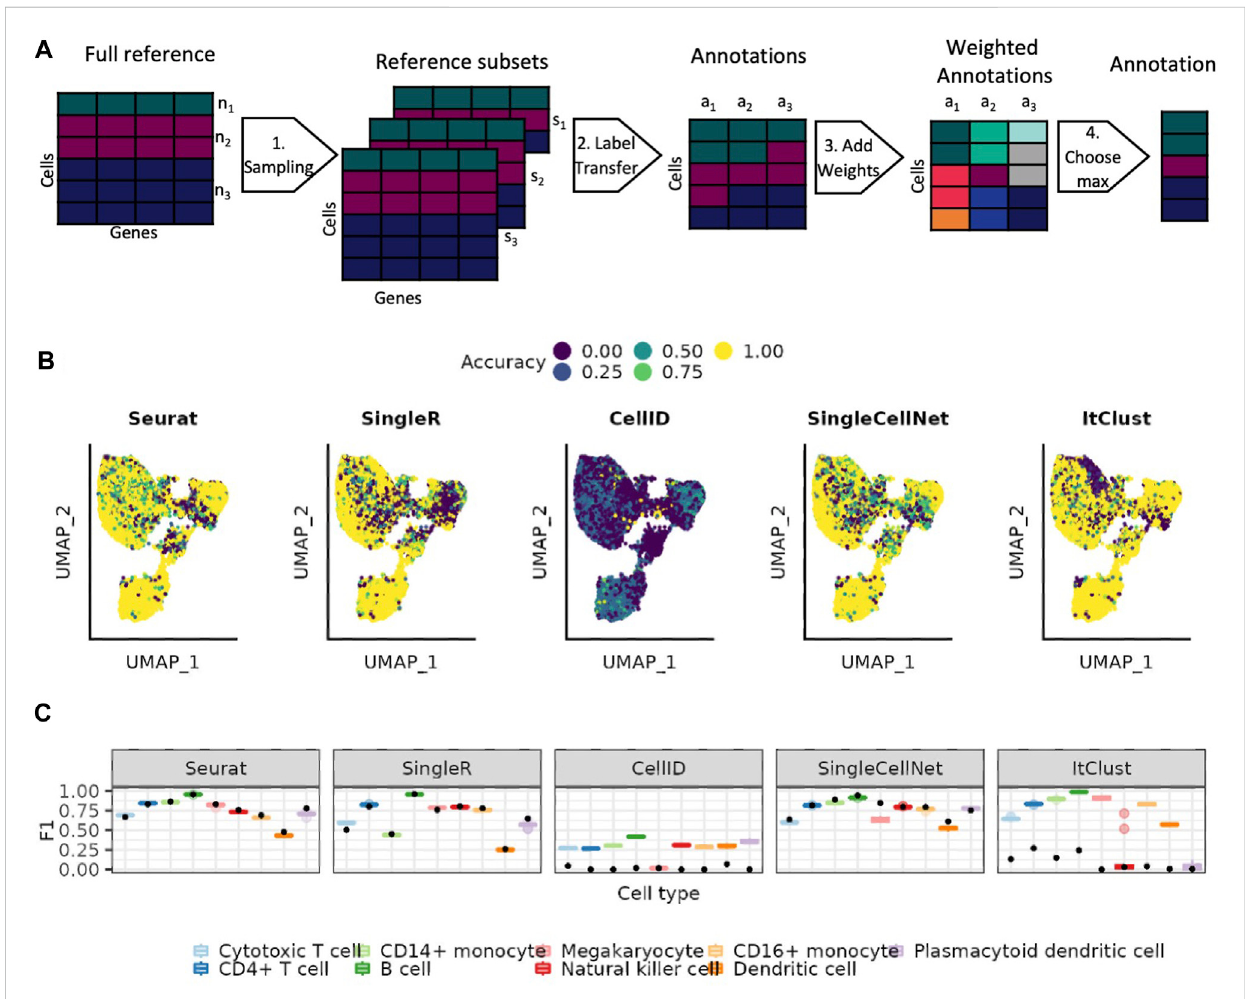
FIGURE 3 Using weighted bootstrapping for thepredictions. (A) Overview of the weighted bootstrapping approach. (1) Sampling of thereference dataset with each subset responding to thesize of one of the cell types present inthe full reference. (2) Cell type label transfer with one of the existing approaches. (3) Addingweightstotheannotationsbasedonhowwellrepresentedthecelltypeisinthecorrespondingreferenceset.(4)Predictingthecelltypeforwhich the sum of predictions is the highest. (B) UMAP colored by the difference between the mean accuracy achieved when using the bootstrapping- based approach versus theone achieved on theindividualreference subsets. (C) Distribution of theF1 scorers for theindividual referencesubsets shown as boxplots (see Methods). The black points represents the result achieved on the full reference